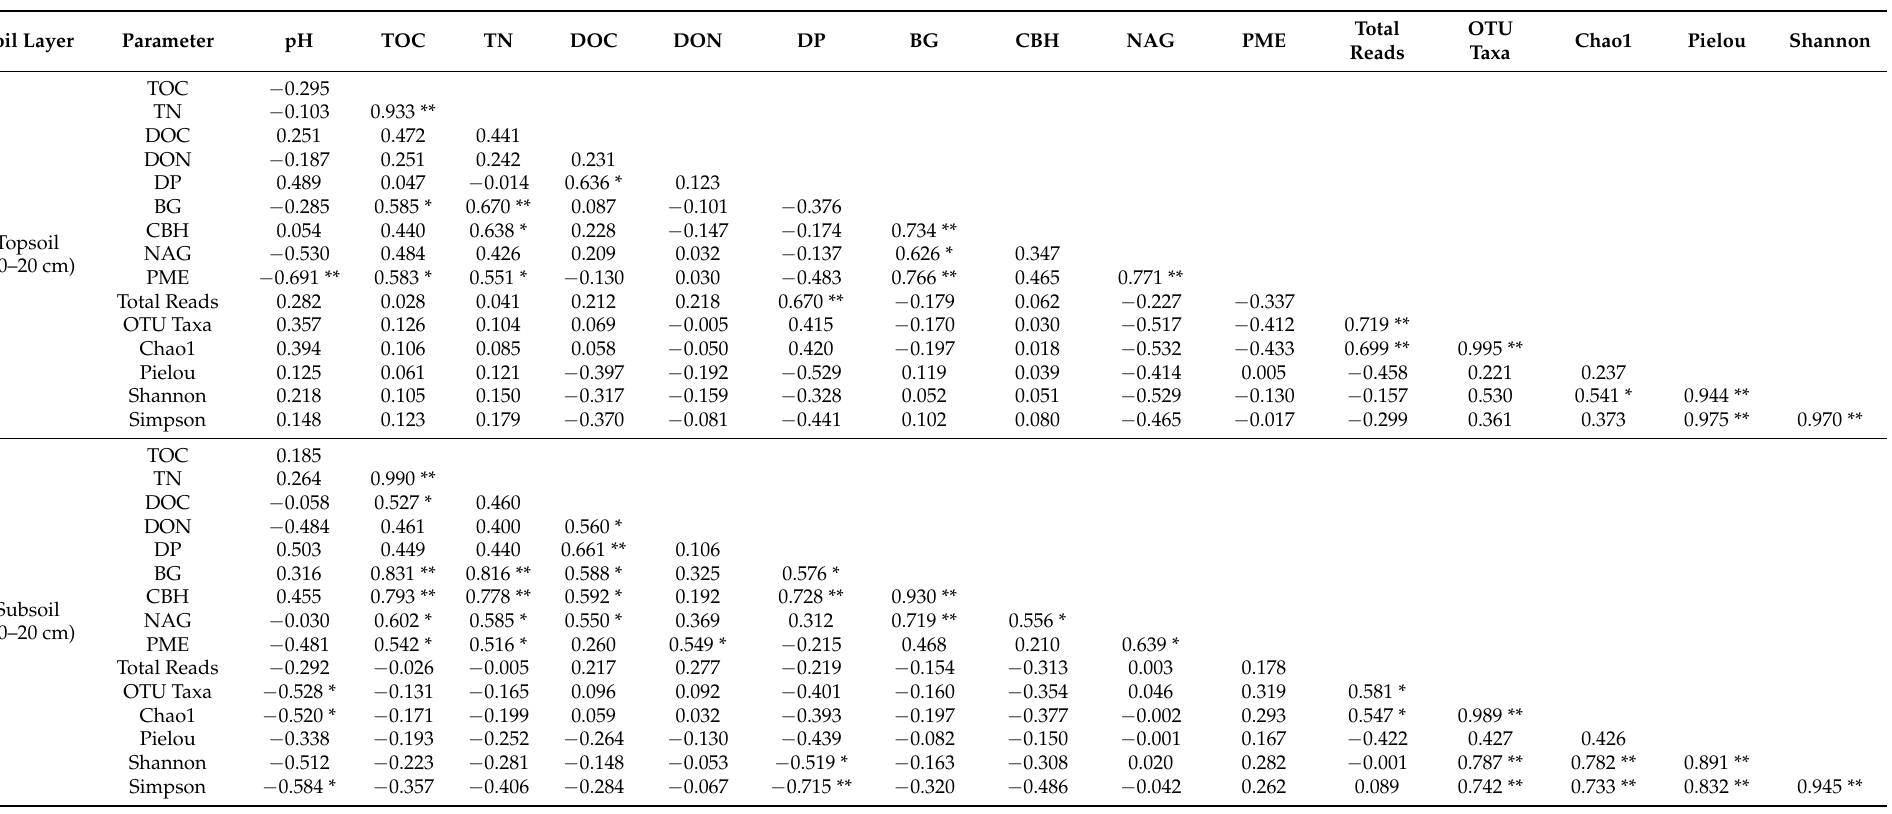
Table 4. Pearson correlation coefficients between soil chemical properties, enzyme activities and microbial